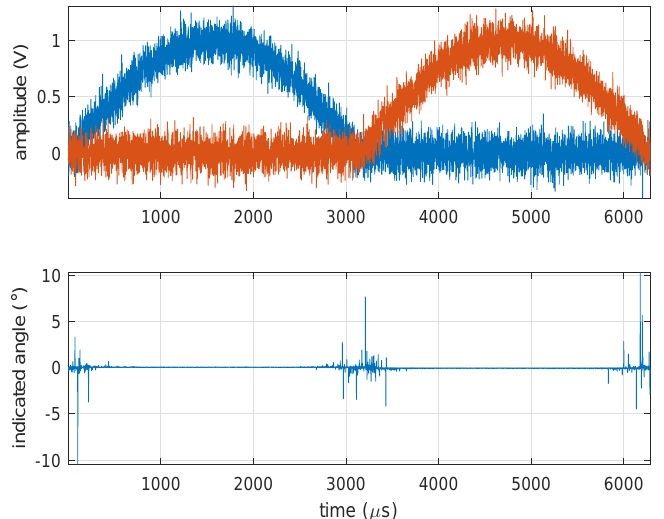
Figure 4. Two amplitude modulated blink jamming signals with a signal-to-noise ratio of 20 dB are simulated using (11), demonstrating the noise effects in the indicated angle as the two signals approach zero